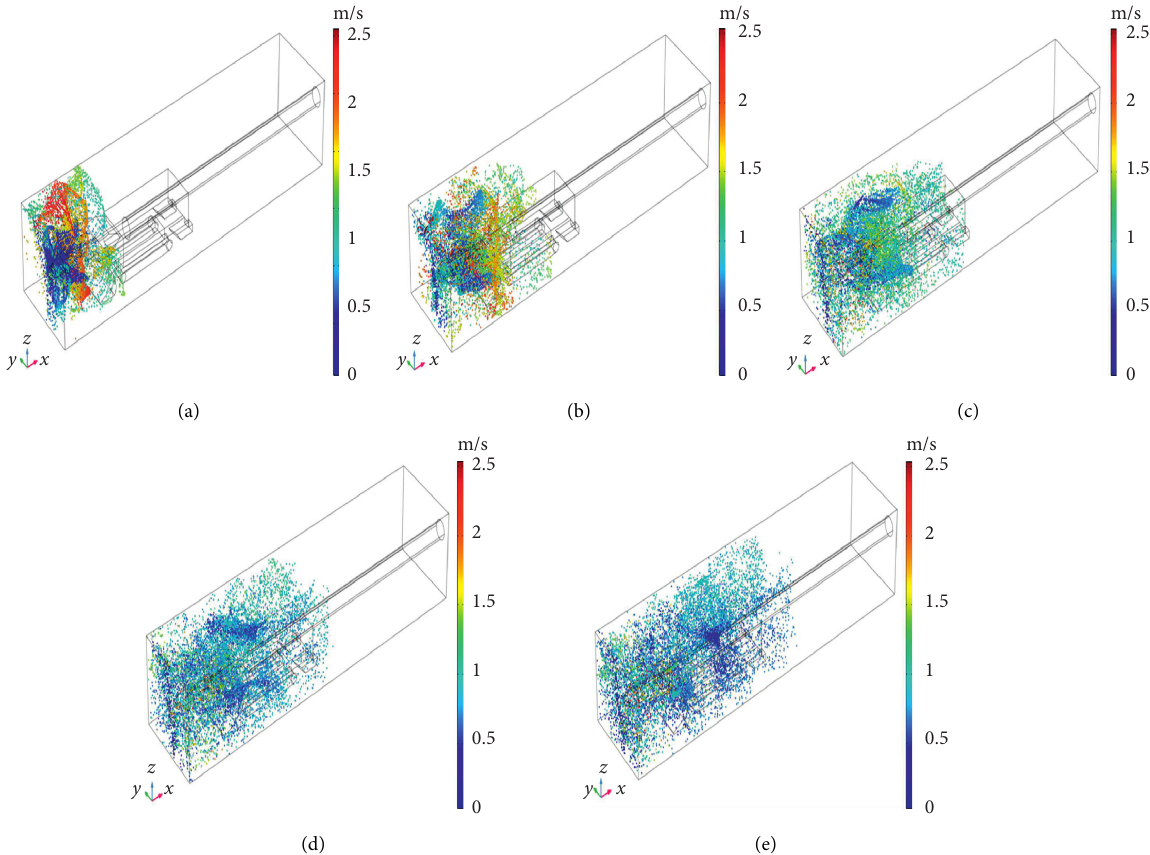
Figure 3: Trajectory of dust particles: (a) t � 2s, (b) t � 4s, (c) t � 6s, (d) t � 8s, and (e) t �